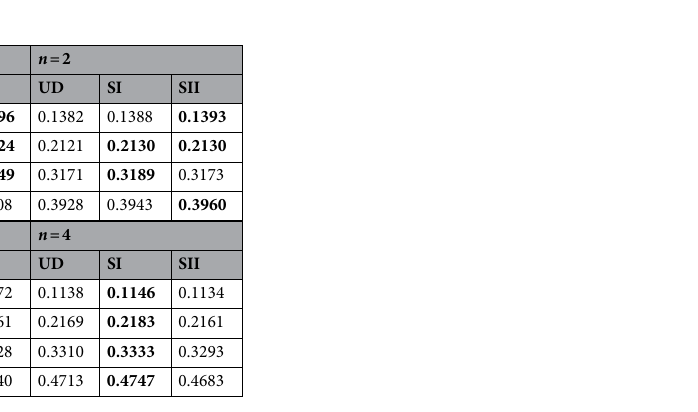
Table 5. Dependency of the natural frequencies on the pore distribution pattern. Significance values are given in bold.